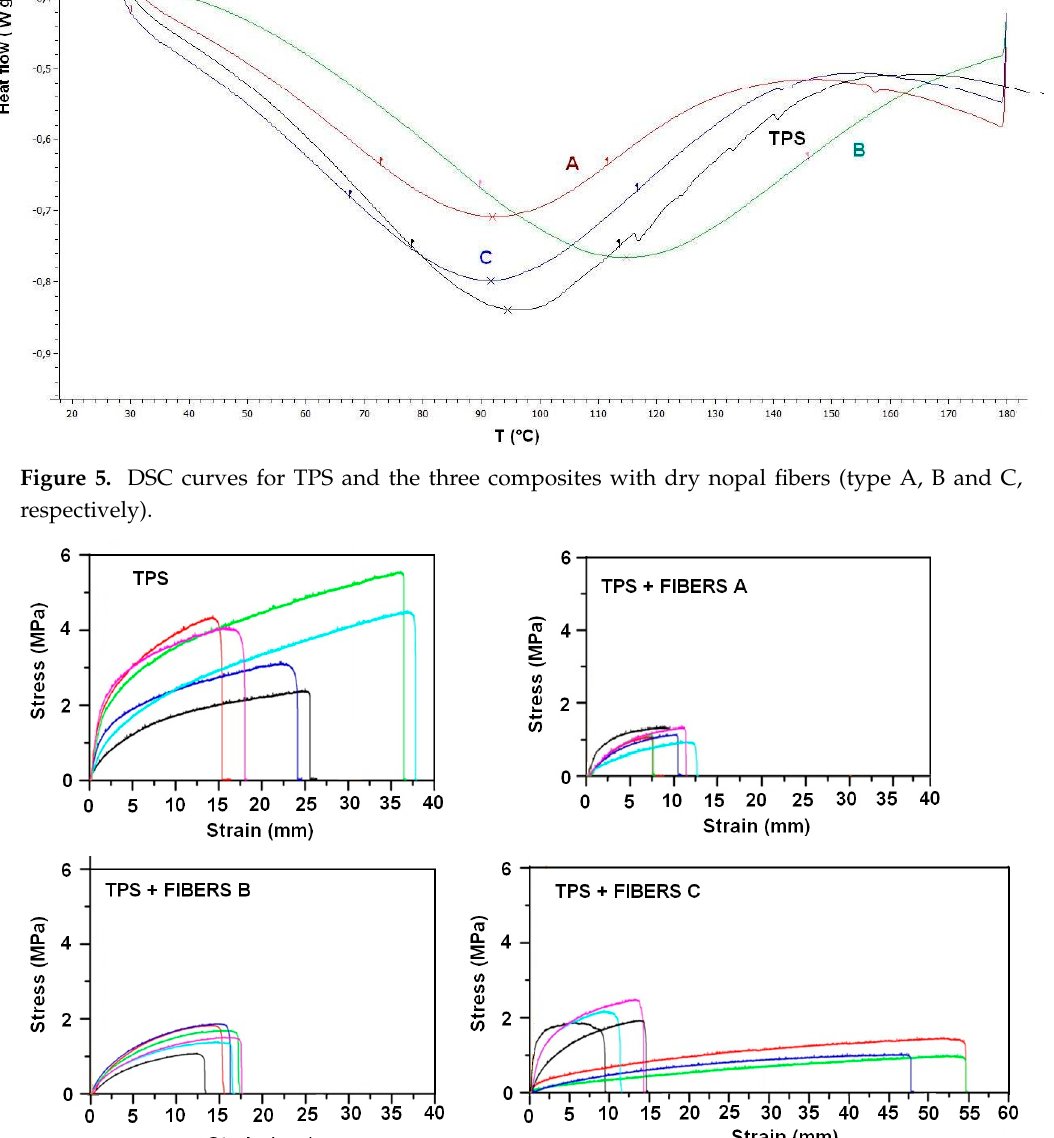
Figure 6. Tensile curves of thermoplastic starch (TPS) and its composites with dry nopal fibers (colors represent the curves for the di ff erent samples